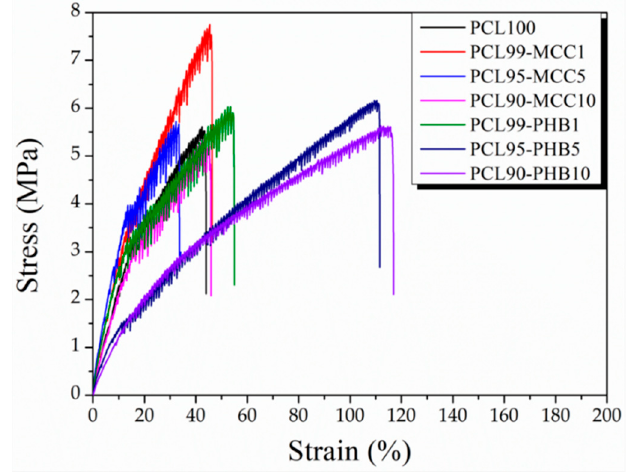
Figure 7. Stress–strain curves for electrospun neat PCL, PCL-MCC and PCL-PHB blends.